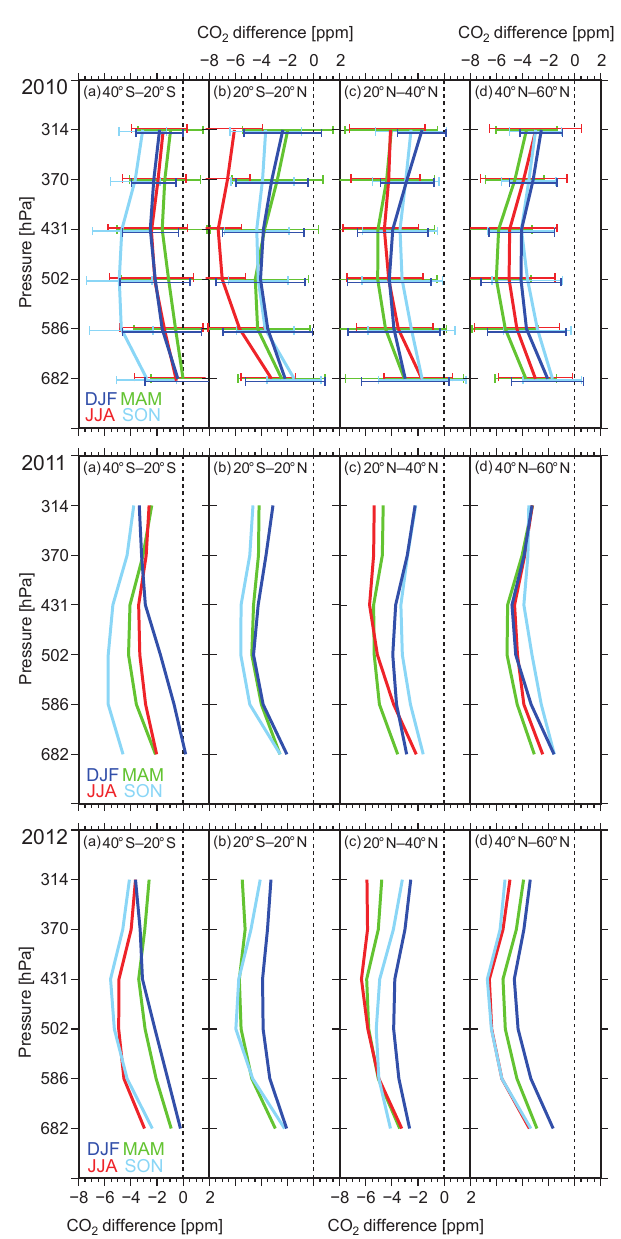
Figure 6. Average differences in CO 2 concentrations between GOSAT/TANSO-FTS TIR and CME_AK CO 2 data (TIR minus CME_AK) from 736 to 287hPa (retrieval layers 3–8) for each lat- itude band and season, 2010–2012. The 1 σ standard deviations of the averages are indicated by horizontal bars for comparison of 2010 as a reference, which are slightly shifted up and down for visi- bility. We divided the data into four latitude bands: (a) 40–20 ◦ S, (b) 20 ◦ S–20 ◦ N, (c) 20–40 ◦ N, and (d) 40–60 ◦ N. Green, red, light blue, and blue lines represent the results in northern spring (MAM), northern summer (JJA), northern fall (SON), and northern winter (DJF),